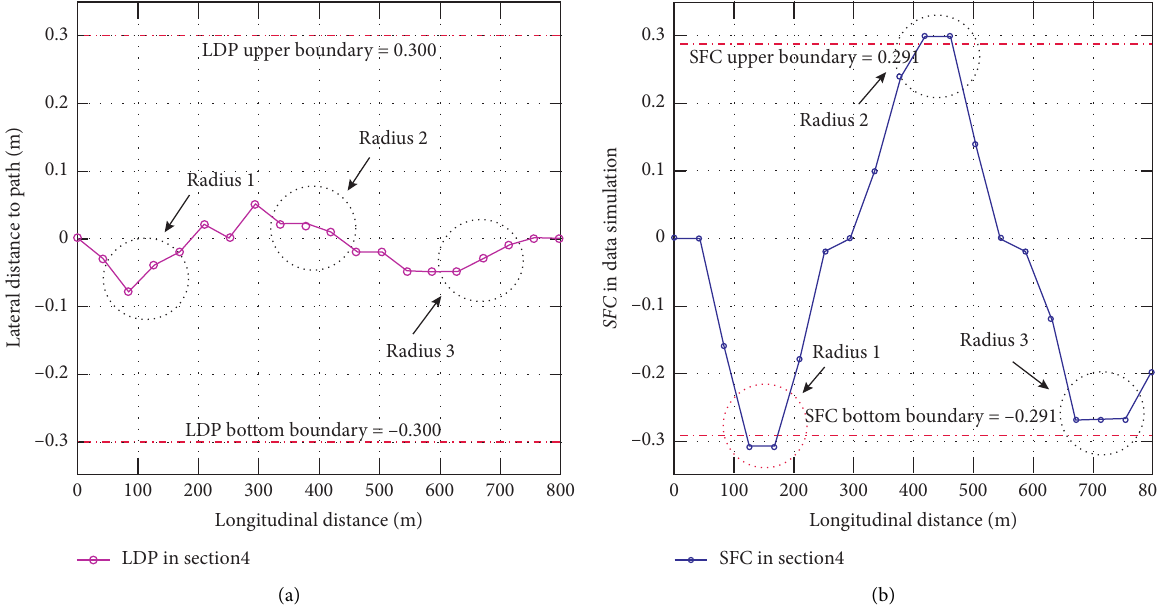
Figure 11: The simulation results of Section 4. (a) Lateral Distance Path Change Trend. (b) SFC Change Trend.